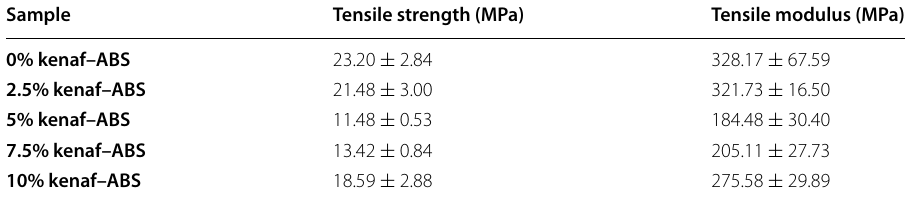
Table 3 Tensile strength and modulus for all samples Sample Tensile strength